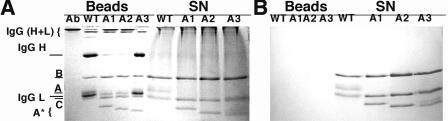
Immunoprecipitation of CDT Complexes Containing Deletion Mutants of CdtA(A) The complexes (10 μg each) were immunoprecipitated with 10 μg anti-myc antibody (myc tag was fused to C-terminus of CdtC) in 150 mM NaCl, 20 mM HEPES (pH 7.5), 0.1% Nonidet P40 substitute, followed by exposure to protein G Sepharose beads, and subjected to nondenaturing SDS-PAGE.(B) Nonspecific binding of CDT complexes to protein G Sepharose was not detected under the same experimental conditions. A, CdtA; B, CdtB; C, CdtC; A*, truncated CdtA; A1, holotoxin with CdtA Δ18−56; A2, holotoxin with CdtA Δ18−67; A3, holotoxin with CdtA Δ18−75; WT, wild-type; Ab, only anti-myc antibody, no CDT; IgG (H+L), nonreduced immunoglobulin G; IgG H, immunoglobulin G heavy chain; IgG L, immunoglobulin G light chain; SN, supernatant.